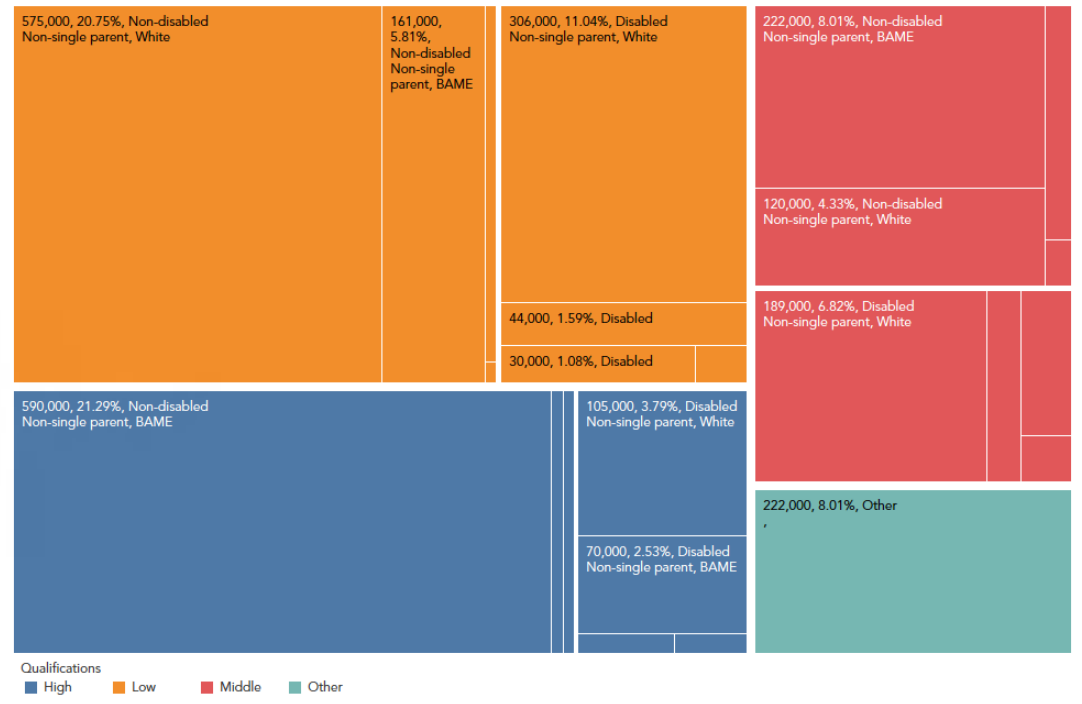
Figure 6: White, low-qualified, people without disabilities, who are not single parents, accounted for the biggest increase in employment since 2008 Composition of net employment growth by ‘low-activity’ characteristic, 16+ year olds: